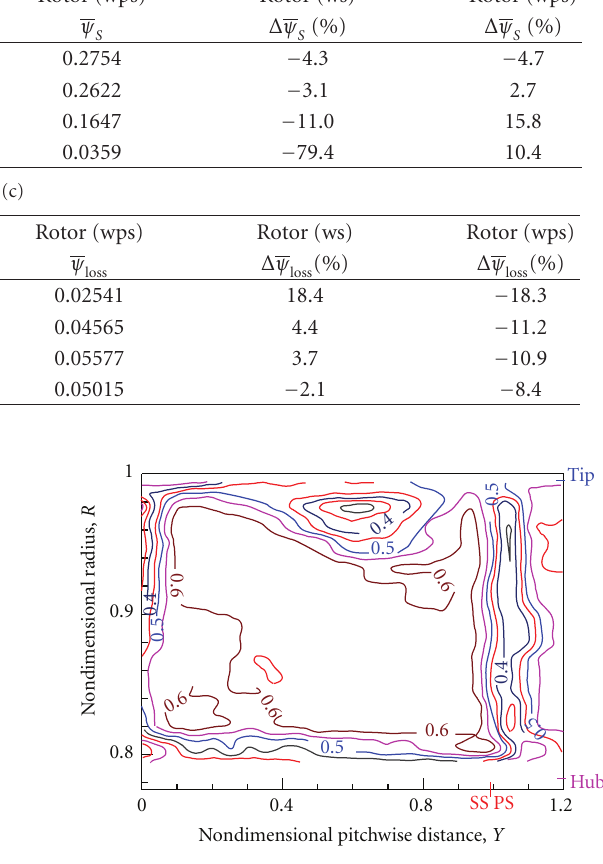
Figure 10: Axial velocity contours at the exit of rotor (wos) for φ = 0 .